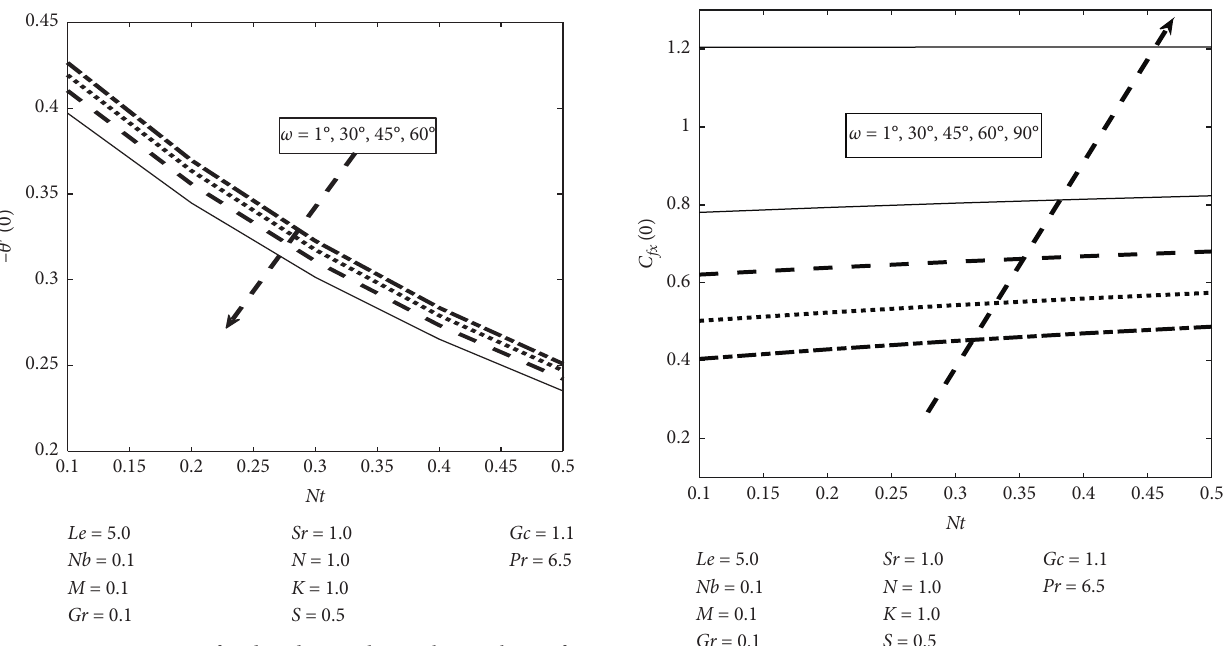
Figure 22: Variations of reduced Nusselt number with Nt for different values of ω .